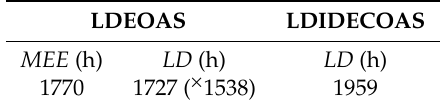
Figure 8. Air condition after passing through the MEE in the LDEOAS. Table 5. Operating time of each component.